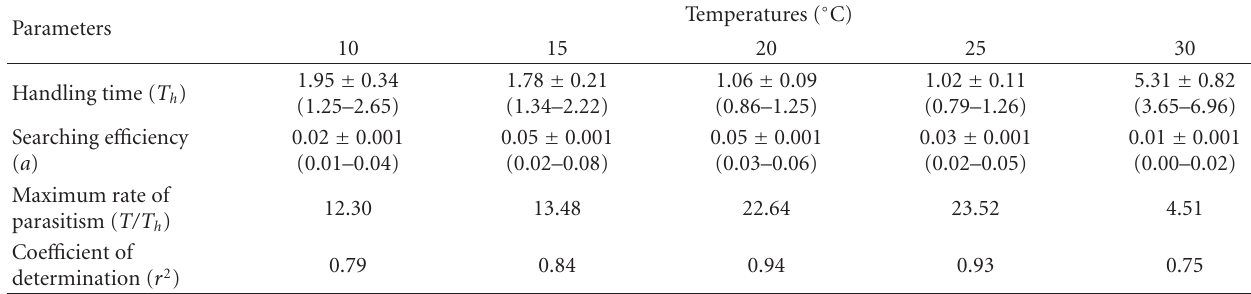
Table 2: Mean ± SE (minimum-maximum) estimates of handling time ( T h ), searching e ffi ciency ( a ), and maximum rate of parasitism ( T/T h ) of Praon volucre on Sitobion avenae .